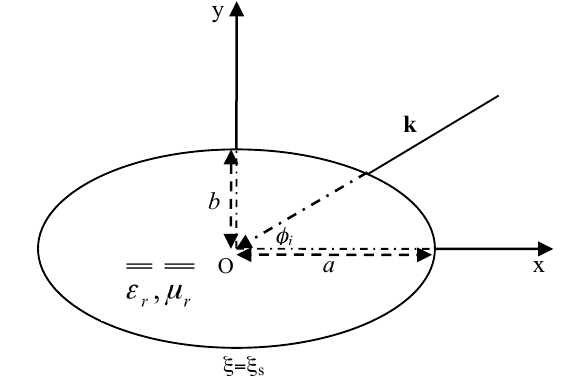
Figure 1: Geometry of the